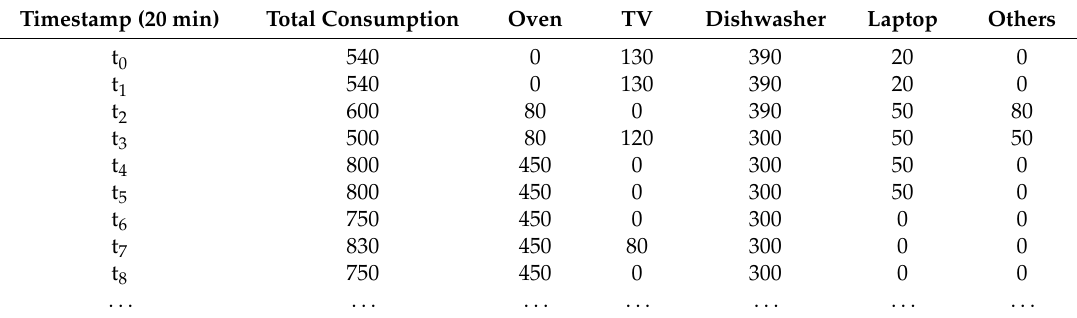
Table 1. A simulated example of the energy disaggregation